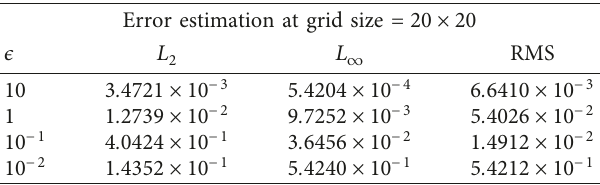
Table 4: Error norm of finite volume by varying ϵ for unknown u ( p,q,t ) .